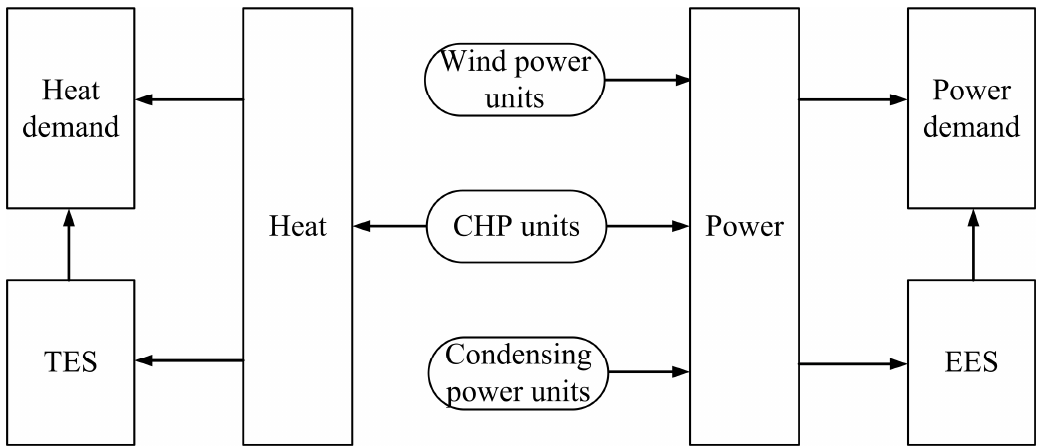
Figure 1. Energy flow in the integrated CHP system.